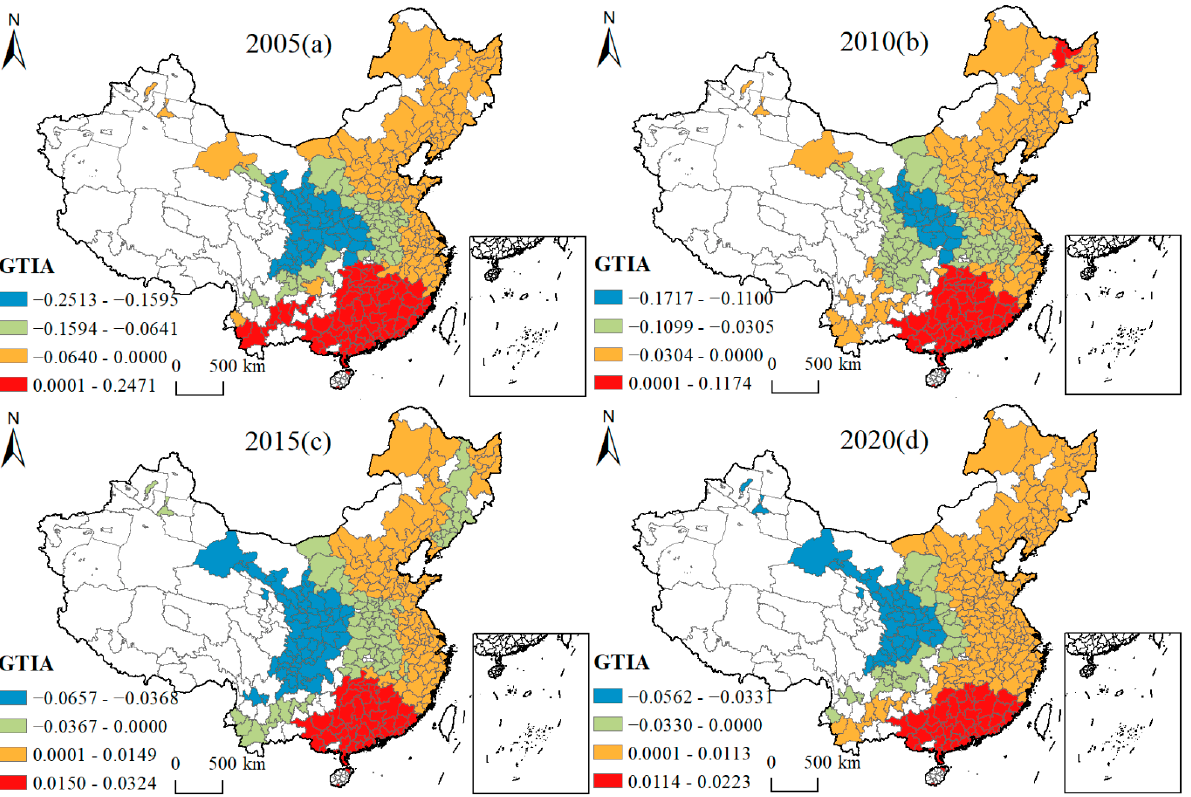
Figure 12. Four-year regression coefficients of GTIA.